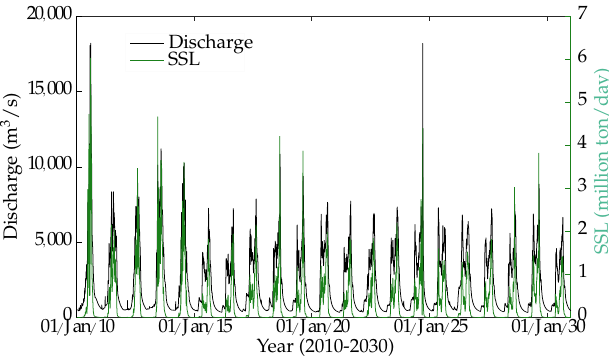
Figure 16. Predicted flow discharge and sediment load at the Tarbela dam.